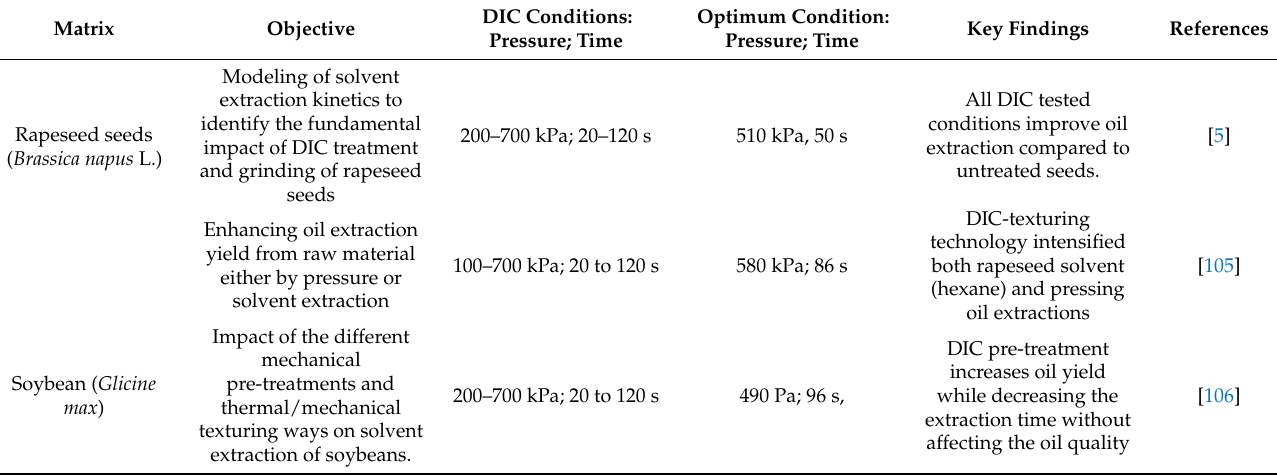
Table 8. Extraction of vegetable oil from raw materials treated by